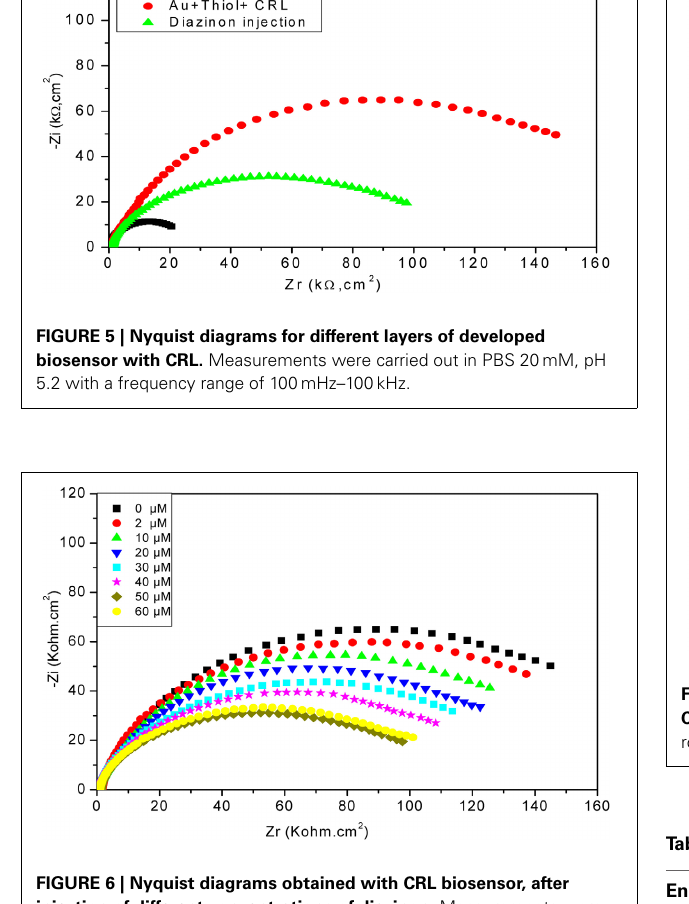
FIGURE 6 | Nyquist diagrams obtained with CRL biosensor, after injection of different concentrations of diazinon. Measurements were carried out in PBS 20mM, pH 5.2 with a frequency range of 100mHz–100kHz.